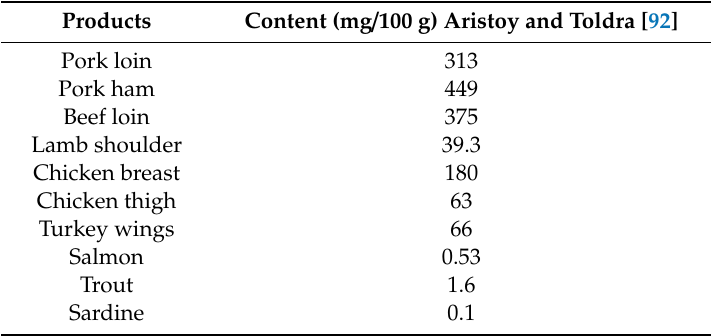
Table 4. Carnosine contents in animal origin foodstu ff